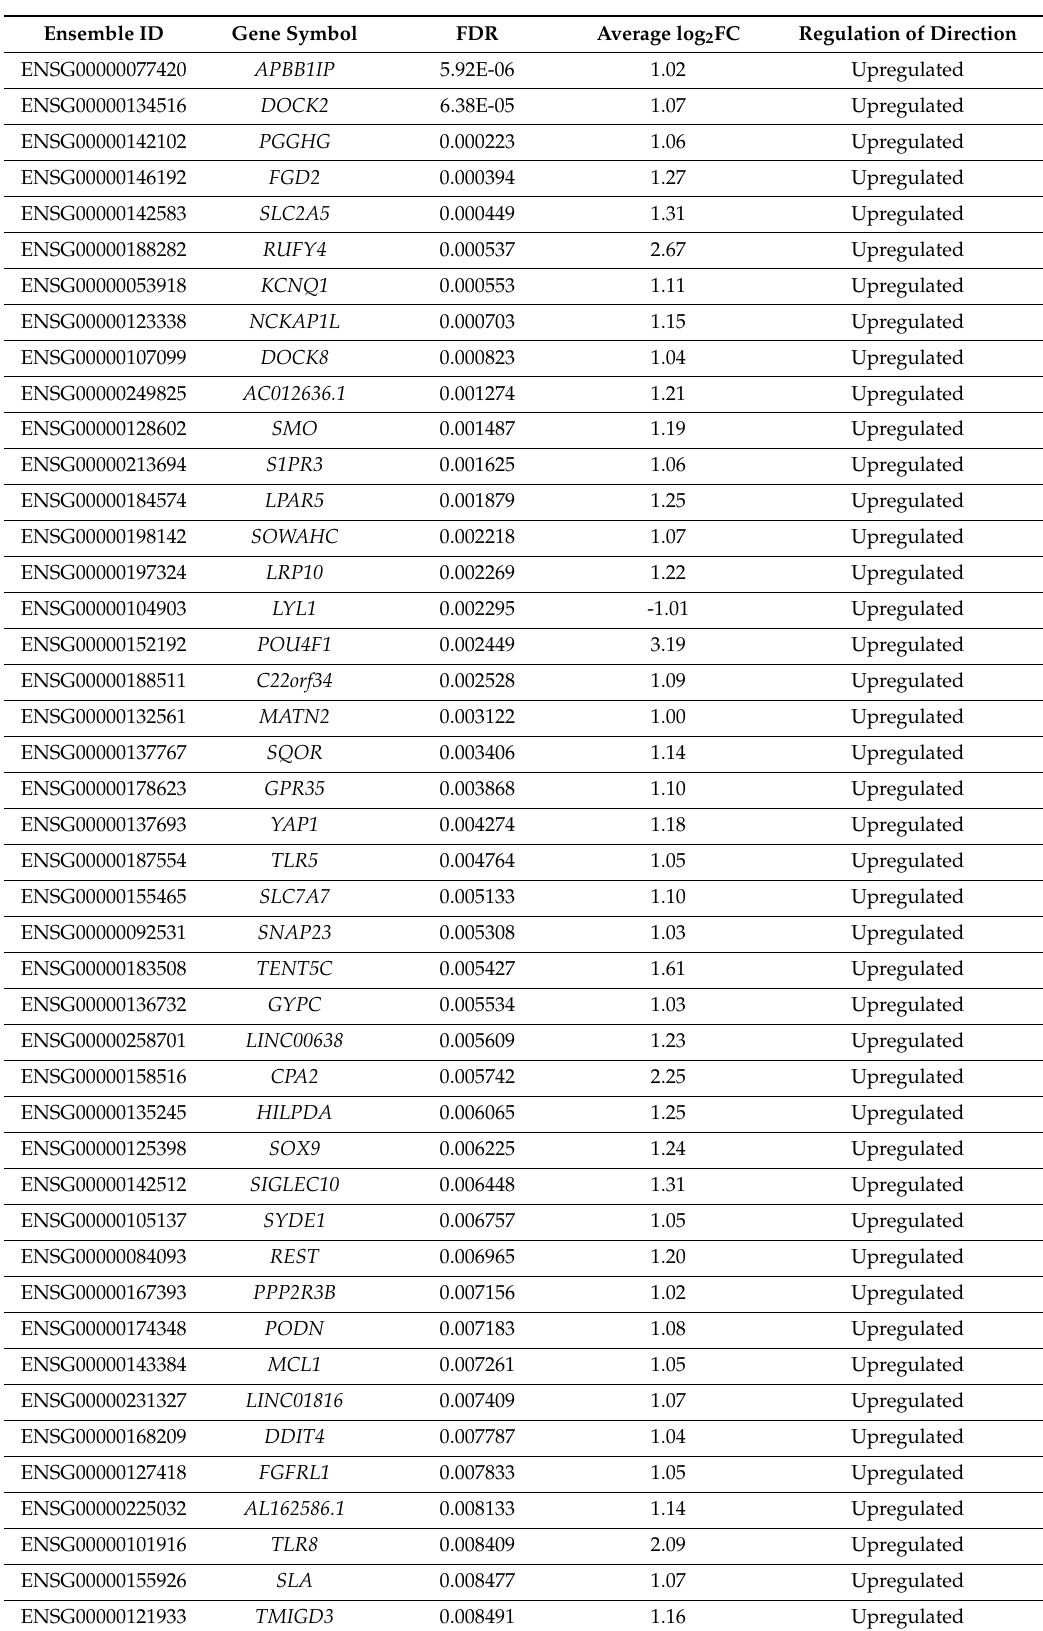
Table 2. Newly di ff erentially expressed genes newly identified in the